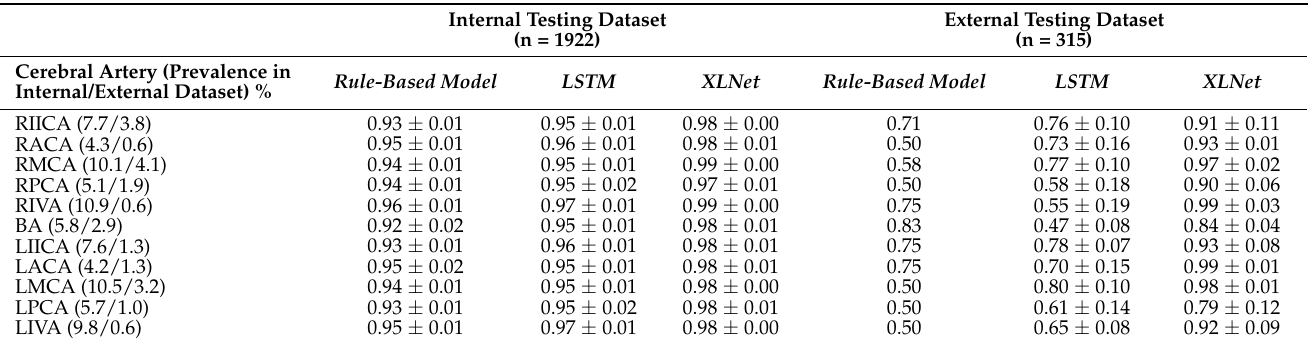
Table 2. Comparison of area under the receiver operating characteristic curve (AUROC) results between internal and external testing datasets for the stenosis-identification task from three different NLP models. Results are expressed as mean ± standard